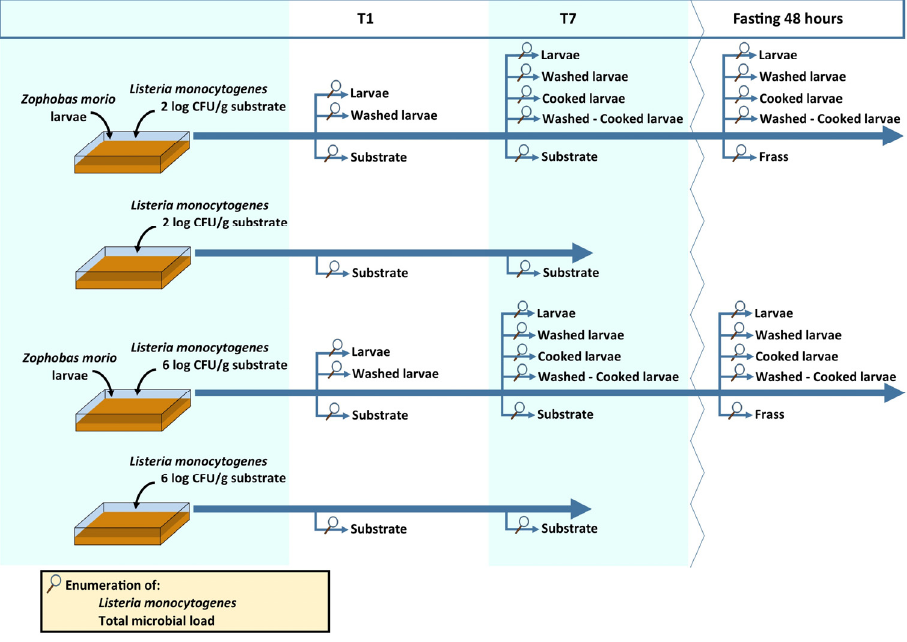
Figure 1. Experimental design of the trial. T1: sampling after 1 day; T7: sampling after 7 days; fasting 48 h: sampling of fasted larvae derived from T7.